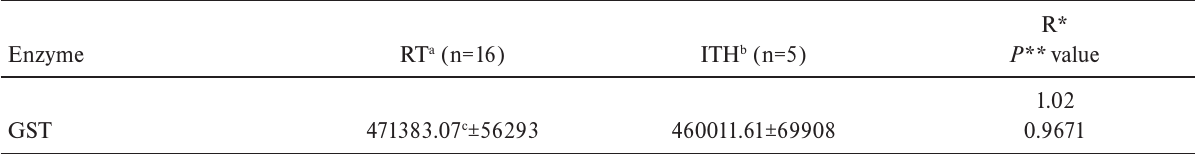
Table 1. Mean GST enzyme activity levels in study